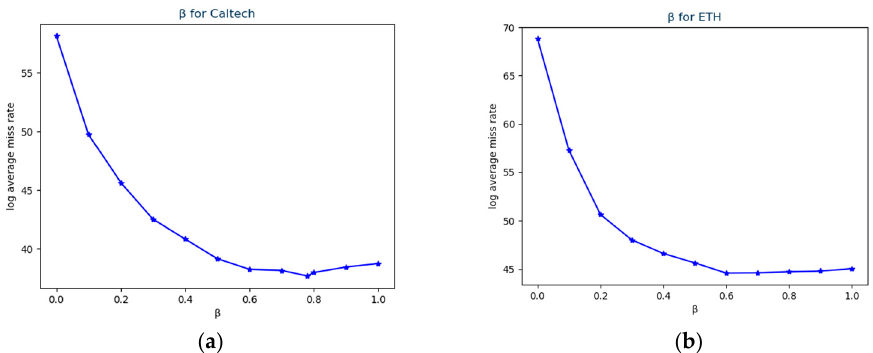
Figure 11. The effect of 𝛽 . ( a ) Caltech test dataset; ( b ) ETH dataset. Figure 11. The e ff ect of β . ( a ) Caltech test dataset; ( b ) ETH dataset.